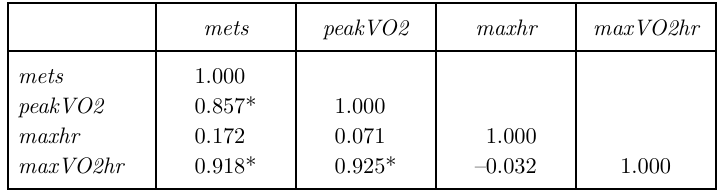
Table 9. Correlation matrix of the selected variables of the cardio-respiratory system mets